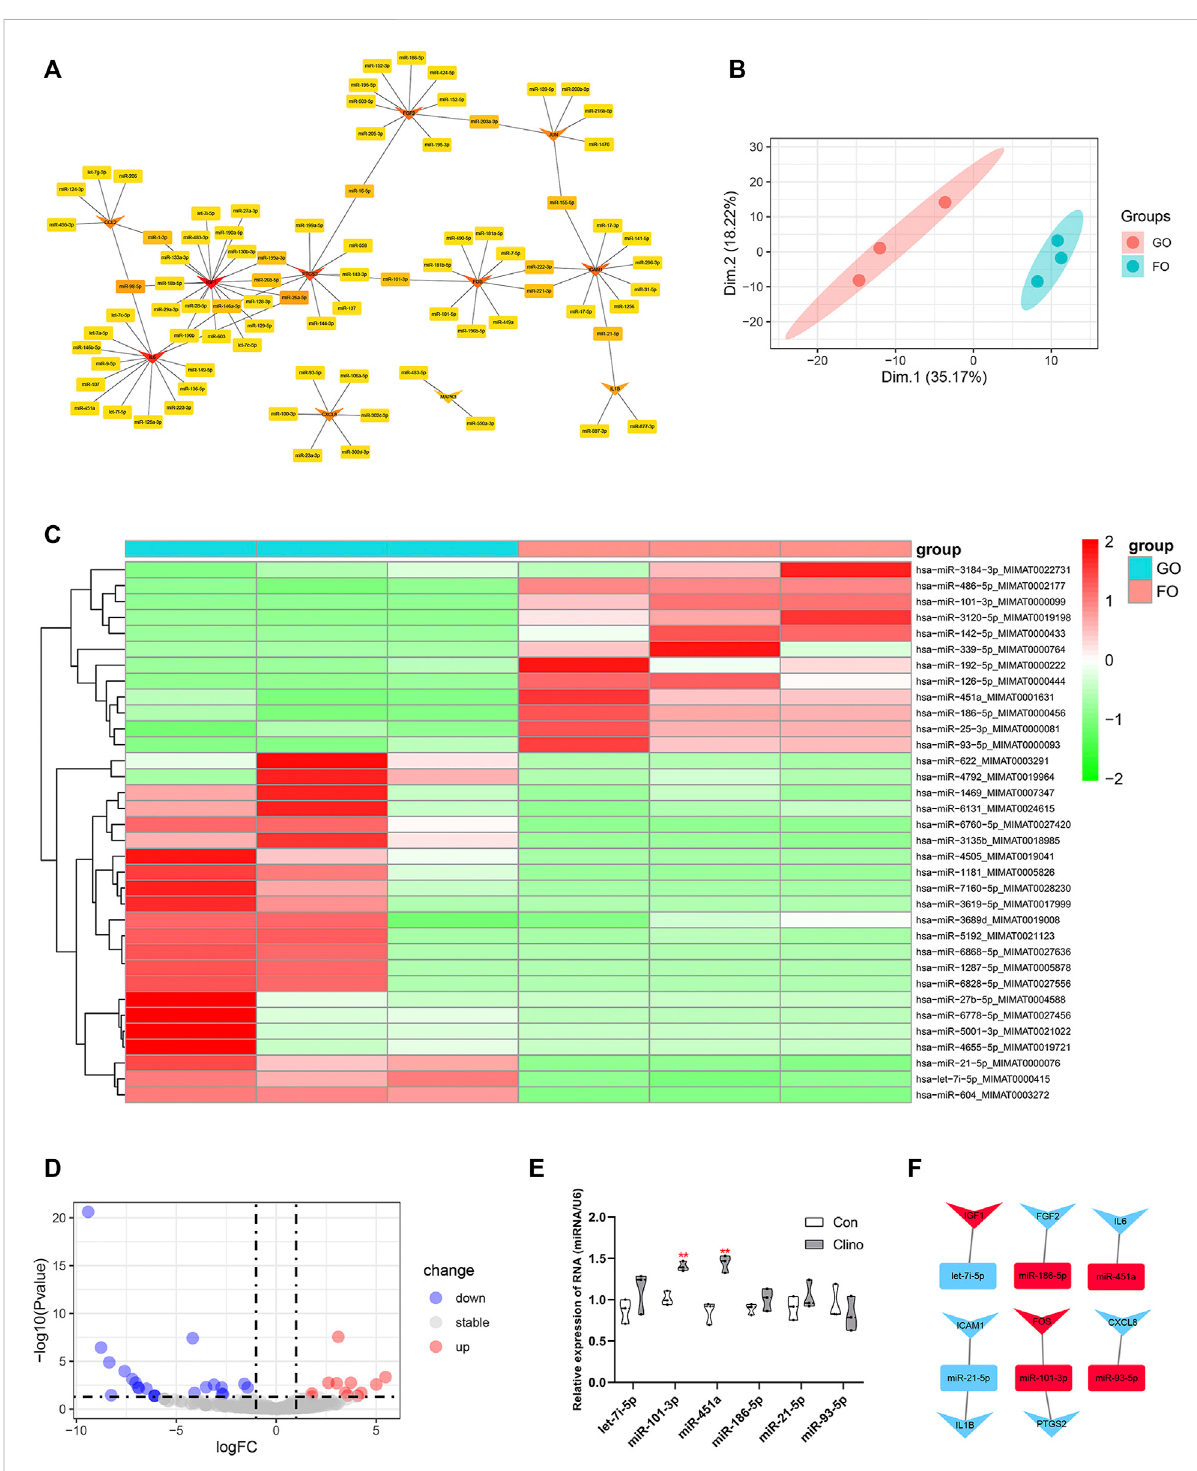
FIGURE 5 Identi fi cation of crucial miRNA-mRNA axes in microgravity-induced bone loss (A) Coexpressed network of hub genes and their target miRNAs (B) PCA for miRNA expression in the GSE100932 dataset (C) Heatmap and hierarchical clustering of differentially expressed miRNAs (DEMs) (D) Volcano plot of DEMs (E) qRT-PCR for the expression of six miRNAs in hMSCs under clinorotation-microgravity condition for 72 h. Data are the mean ± SD. * p < 0.05, ** p < 0.01 (F) The interactions between hub genes and microgravity-sensitive